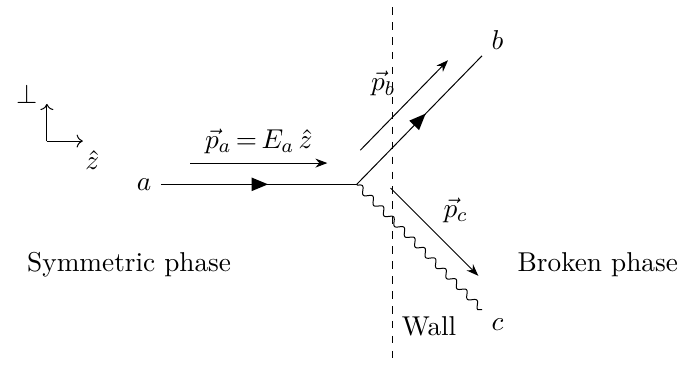
Figure 1 . NLO contribution to the retarding pressure: while approaching the bubble wall, an incoming particle a radiates a vector boson c which gets a mass in the confined